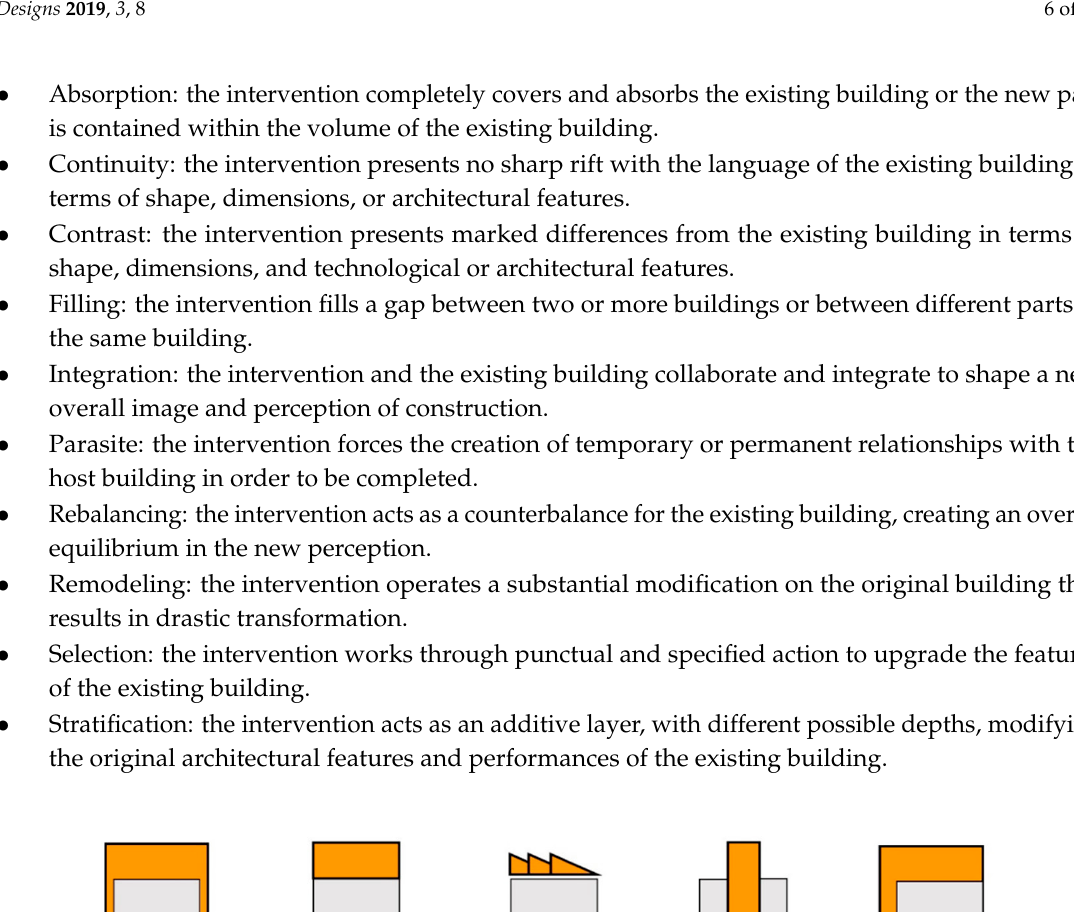
Table 2. Definition of codes and sub ‐ codes.